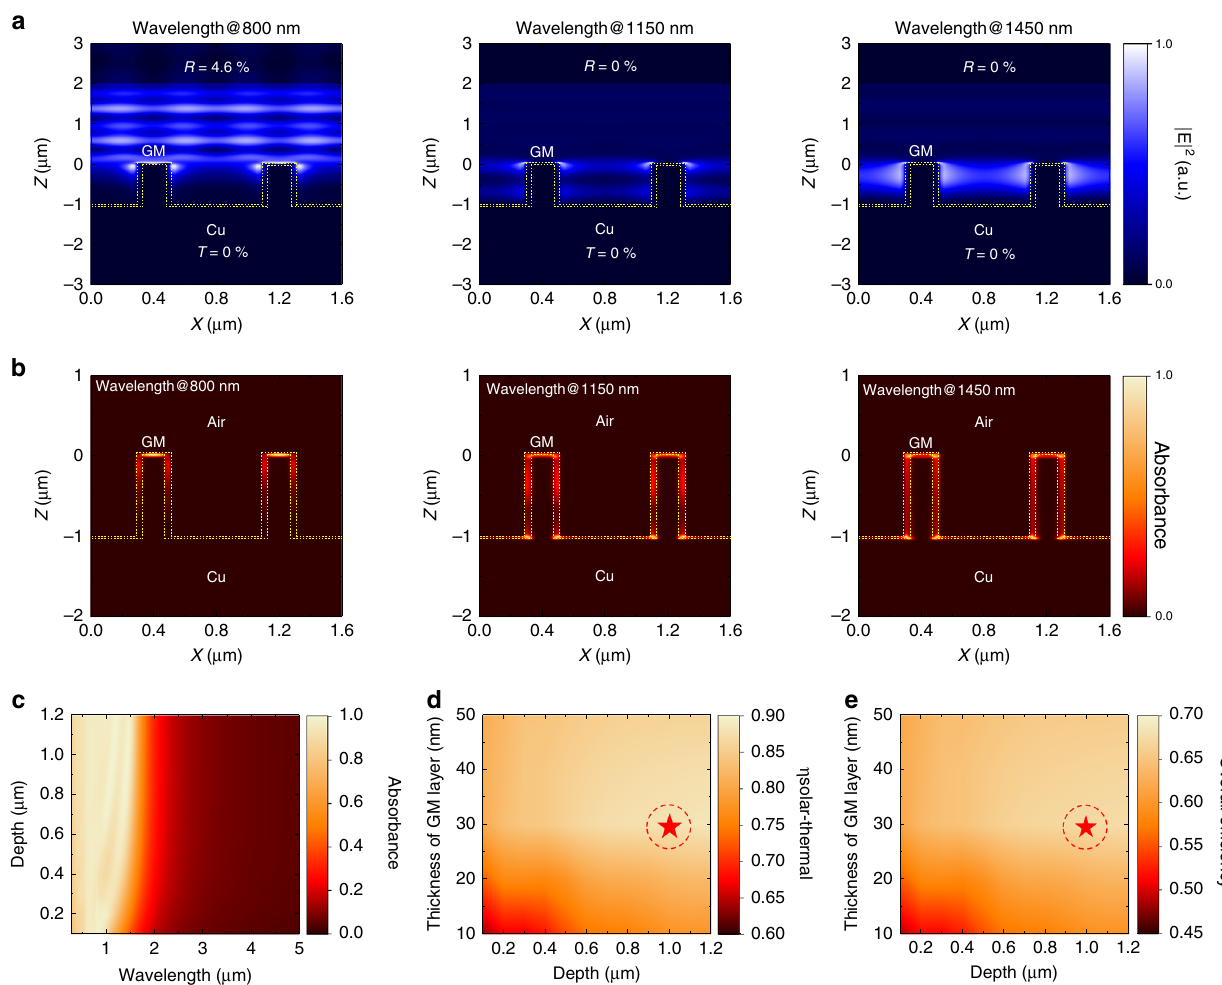
Fig. 2 Optical properties and ef fi ciencies of SGM absorbers. a , b Simulated a electric fi eld intensity distributions and b absorbance map of incident light at various wavelengths (800, 1150, and 1450 nm) passing through the H2 SGM absorber. c Absorption spectra for SGM absorber featuring w = 0.59 µ m, p = 0.8 µ m, and t = 30 nm as a function of depth of trenches and wavelength. d , e Calculated d solar-to-thermal ef fi ciencies and e overall ef fi ciencies of the SGM absorber featuring w = 0.59 µ m and p = 0.8 µ m as a function of thickness of the graphene metamaterial (GM) layer and depth of trenches at T 0 = 298 K, T A = 1273 K, and C = 1000. Circled red star indicates the optimized structural parameters ( d = 1 µ m and t = 30 nm) of SGM